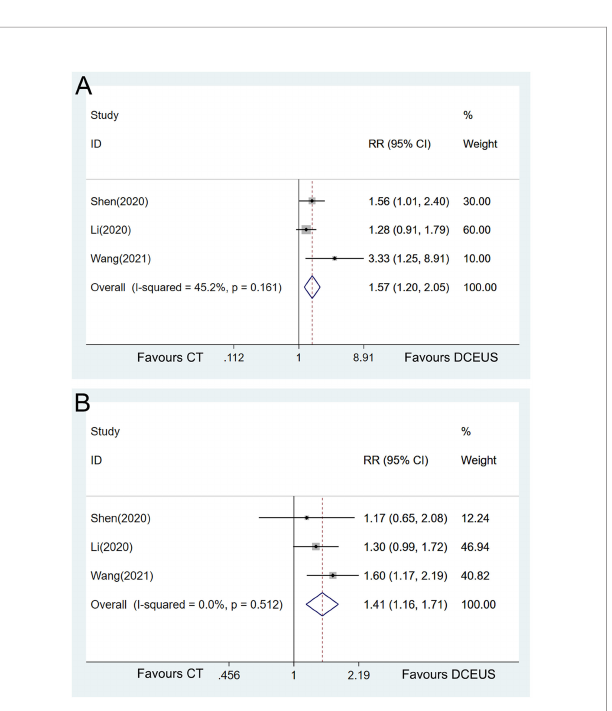
FIGURE 7 | Forest plot showing the pooled effects of diagnostic performance of double contrast-enhanced ultrasonography compared with CT in diagnosing T1 (A) and T2 (B) with only homogeneous studies